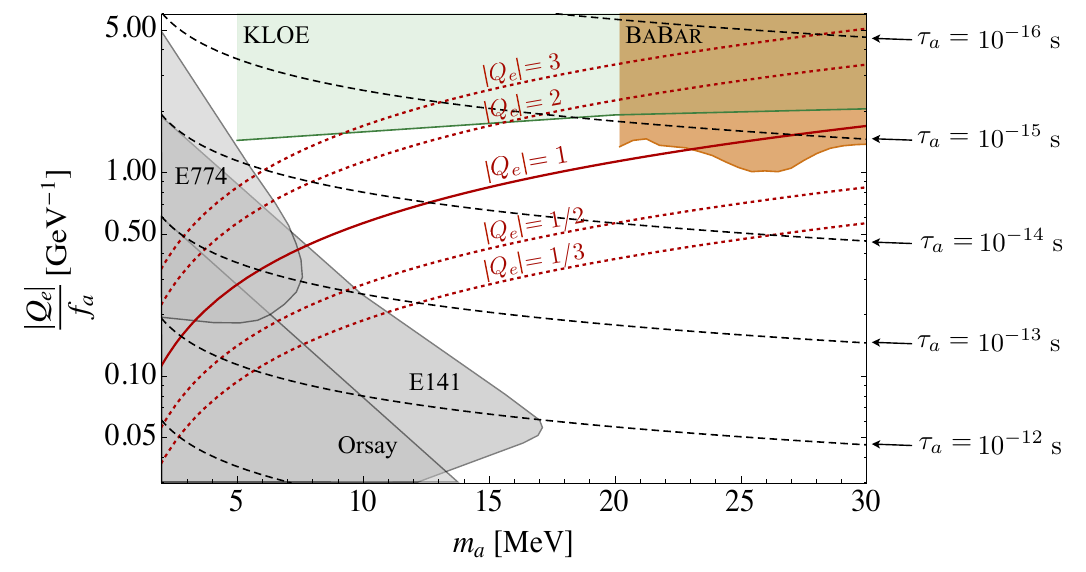
Figure 1 . Existing constraints on the axion-electron coupling for our speci(cid:12)c axion variant. The red curves illustrate the m a vs. j Q e j =f a relation for di(cid:11)erent values of j Q e j . The black dashed lines are contours of the axion’s lifetime. The shaded gray regions are excluded by beam dump experiments [127{129], and the shaded orange and green regions are excluded by BaBar [130] and KLOE [131] searches for dark photons, respectively. Constraints from the electron’s anomalous magnetic moment are model dependent and therefore not shown in this plot (see section 7.2 for